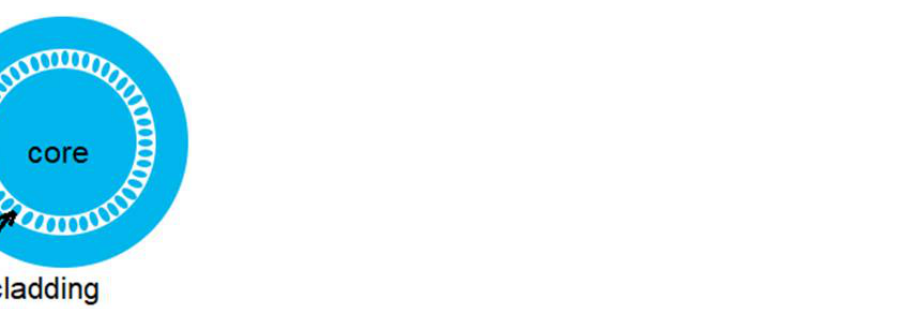
Figure 2. Sketch of cross section of air-clad silica fiber based on the design used in the experiments of [15].